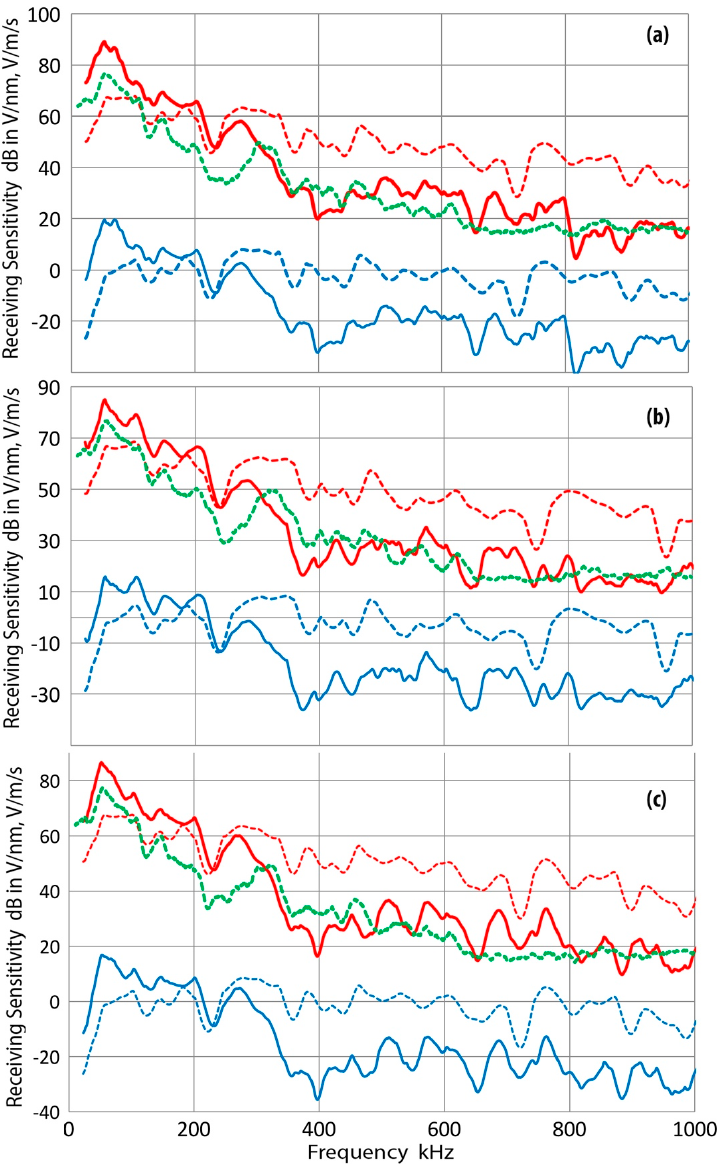
Figure A8. Receiving sensitivity of PAC R6a. ( a ) AI05; ( b ) AI08; ( c ) AI09. The displacement receiving sensitivities are shown in blue curves and velocity sensitivities are in red. Solid lines are for the bar-wave data, while dashed curves are for the sensitivities to normally incident waves. Green curve is the velocity calibration for surface waves from PAC.